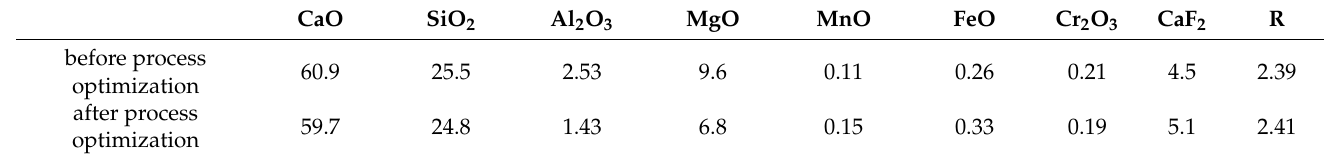
Table 12. Chemical composition of the slag before and after the process optimization